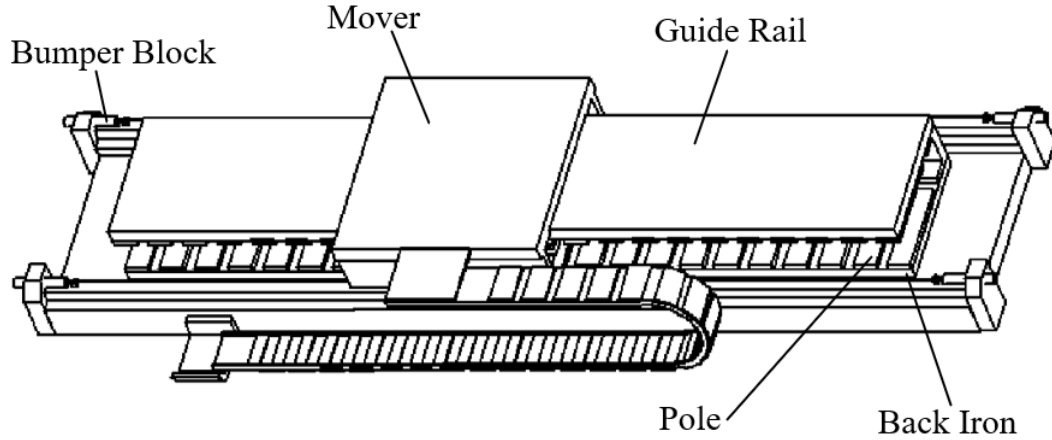
Figure 1. Structure diagram of the PMLSM.